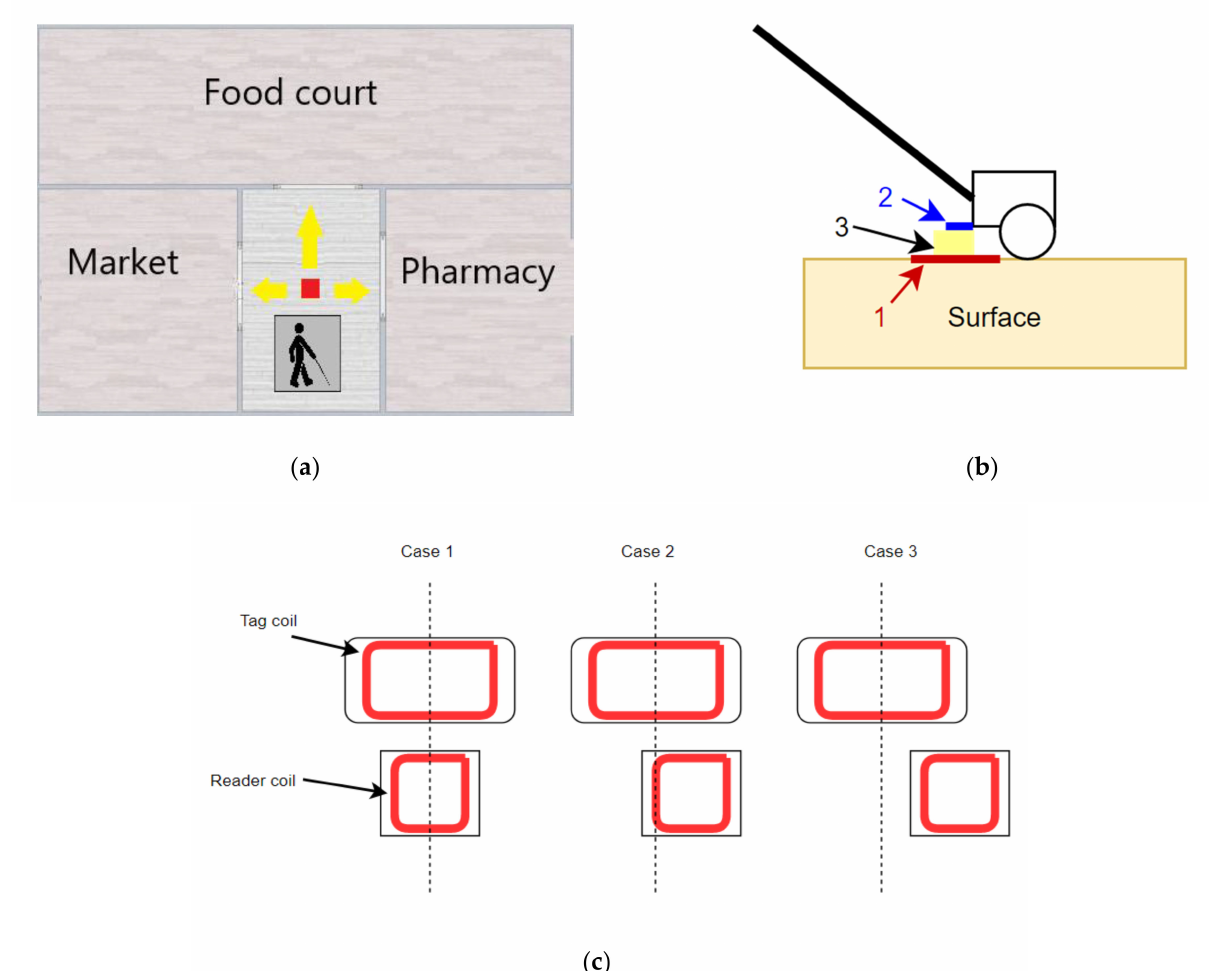
Figure 12. Testing the Inside mode : ( a ) the lobby at the entrance of a building; ( b ) testing the accuracy of the reading according to the distance between components - RFID tag (1), RFID reader (2), distance between RFID tag and reader (3); ( c ) testing the accuracy of the reading according to the alignment between the coils of the RFID tag and reader—centers of the coils are perfectly aligned (Case 1), centre of the tag coil barely intersects the coil of the reader (Case 2), unaligned coils (Case 3). The format of the data read from the RFID tag is “Food_area_nn/Market_ee/Pharmacy_ ww/#”. The values “nn”, “ee”, and “ww” represent the orientation, with respect to the north pole, as in N, S, E, W, NE, NW, SE, or SW. When the user scans an RFID tag, Inside mode compares the user orientation with the location’s orientation and updates the user in real time. To transmit the cardinal point to the user, directions as “Front”, “Left”, “Right”, “Backward”, “Front-left”, “Front-right”, “Backward-right”, and “Backward-left” are used. Every direction has a range of approximately 45